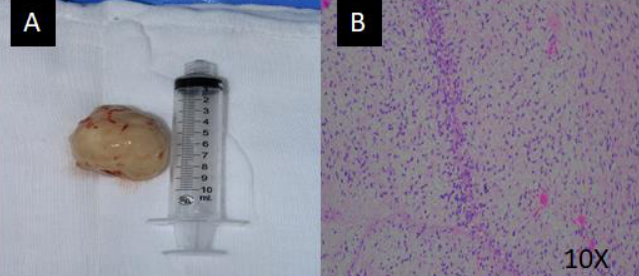
Figure 2. Smooth consistency tumor with small hemorrhagic areas (A); histological hematoxylin eosin stain showing mitotic spindle cells and focal necrosis